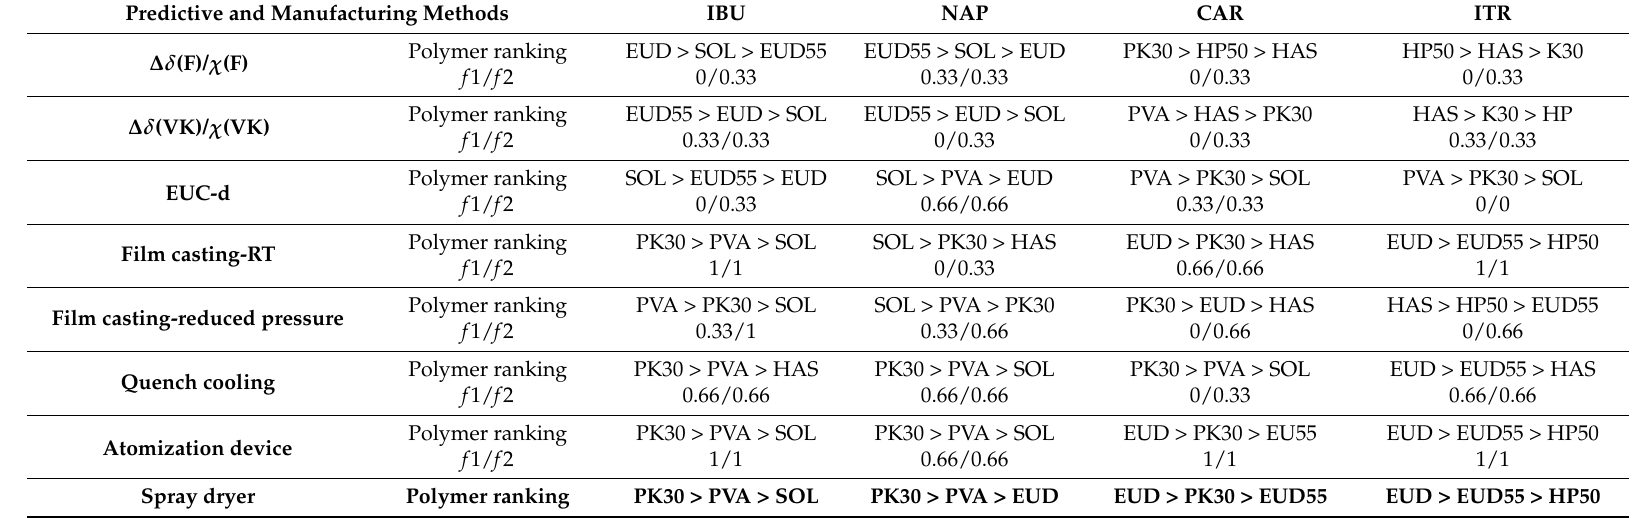
Table 5. Polymer ranks order provided by predictive and spray drying methods for the production of IBU, NAP, CAR, and ITR ASDs. Evaluation of prediction accuracy with the probability calculation of each method to predict the polymer nature ( f 1) and the polymer rank order ( f 2) of spray-dried amorphous solid dispersions